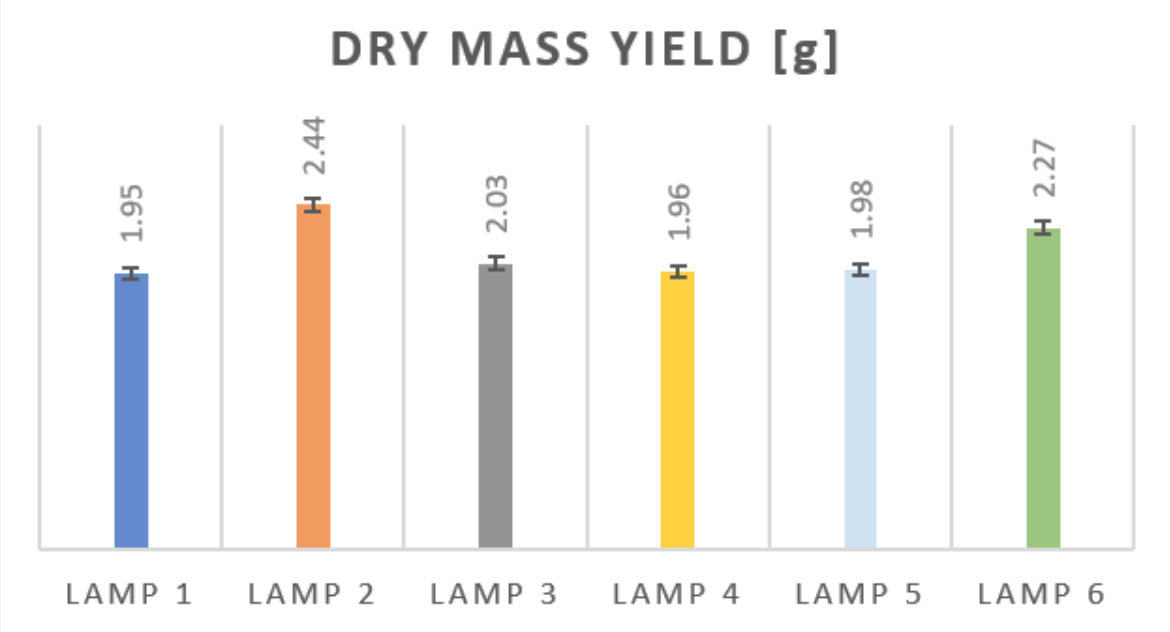
Figure 5. Dry mass yield of the mint harvested. Average value of 7 mint plants was presented for each lighting